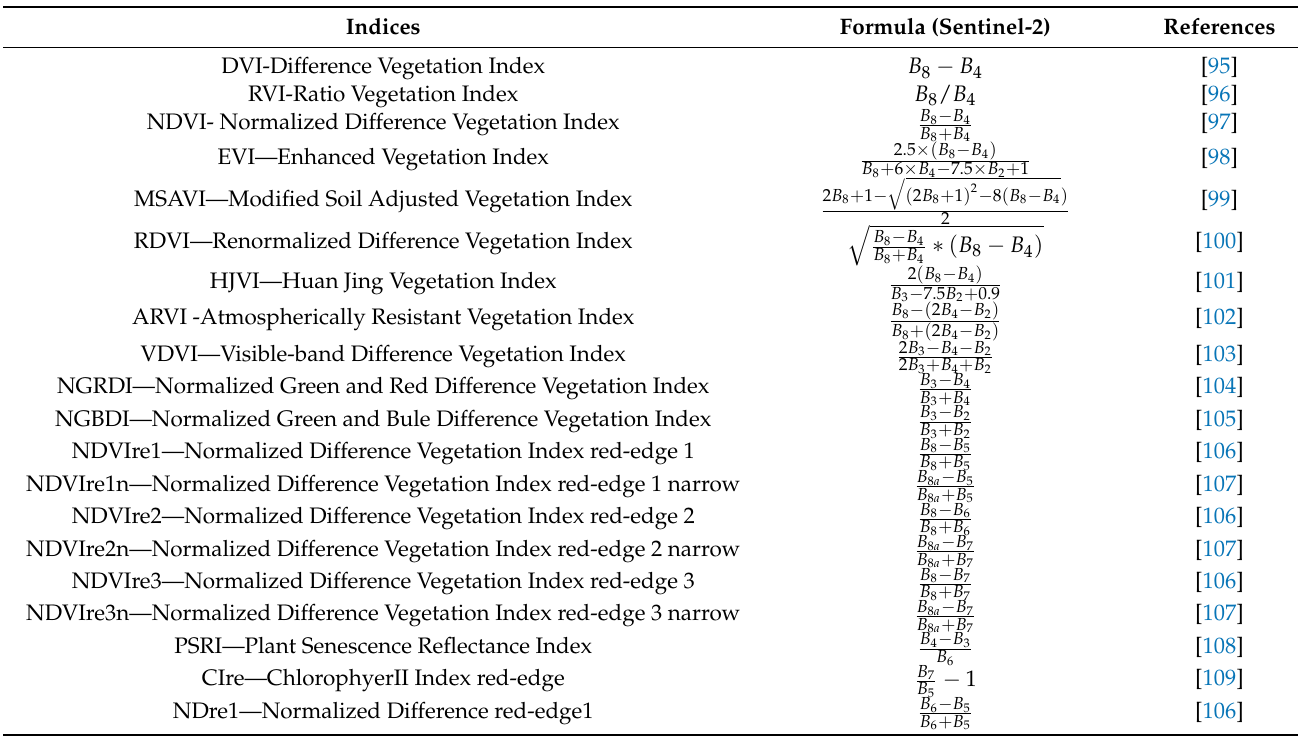
Table A1. Multispectral indices used in this